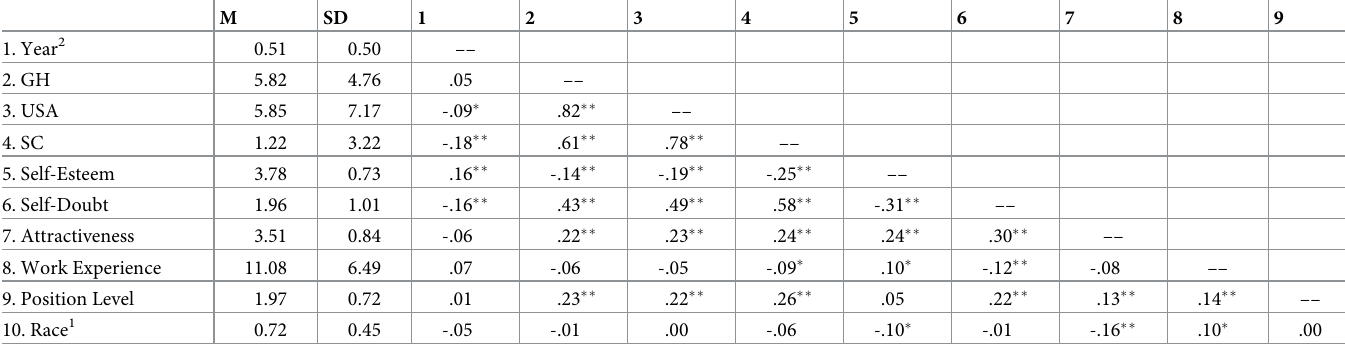
Table 2. Descriptive statistics and correlations for 513 female participants collected using a Qualtrics panel (online survey tool). 1 Race is coded as 0 = not White, 1 = White, 2 Year is coded as 0 = September 2016, 1 = September 2018. ( � P < .05, �� P < .01).